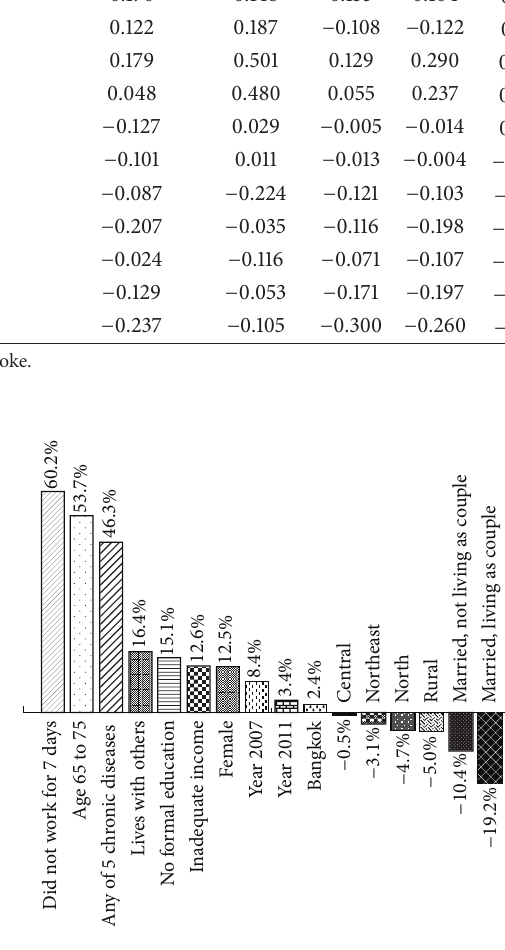
Figure 2: Proportional impacts of modeled independent variables on prevalence of the 6 disabilities